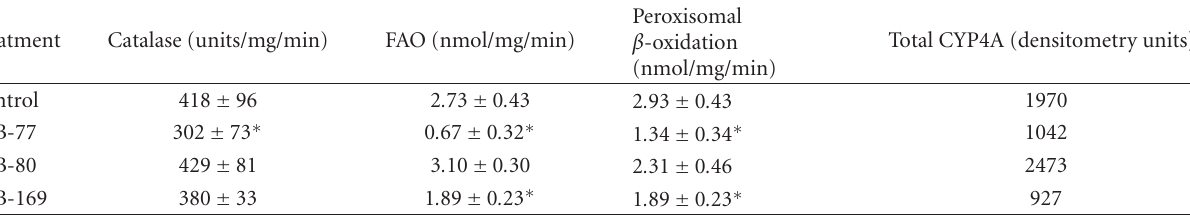
Table 2: E ff ect of PCBs on PPAR α -related enzyme activities and protein